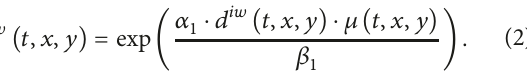
a platform mainly consists of two areas shown in Figure 2: circulating areas and waiting areas. Both waiting behaviors in the waiting